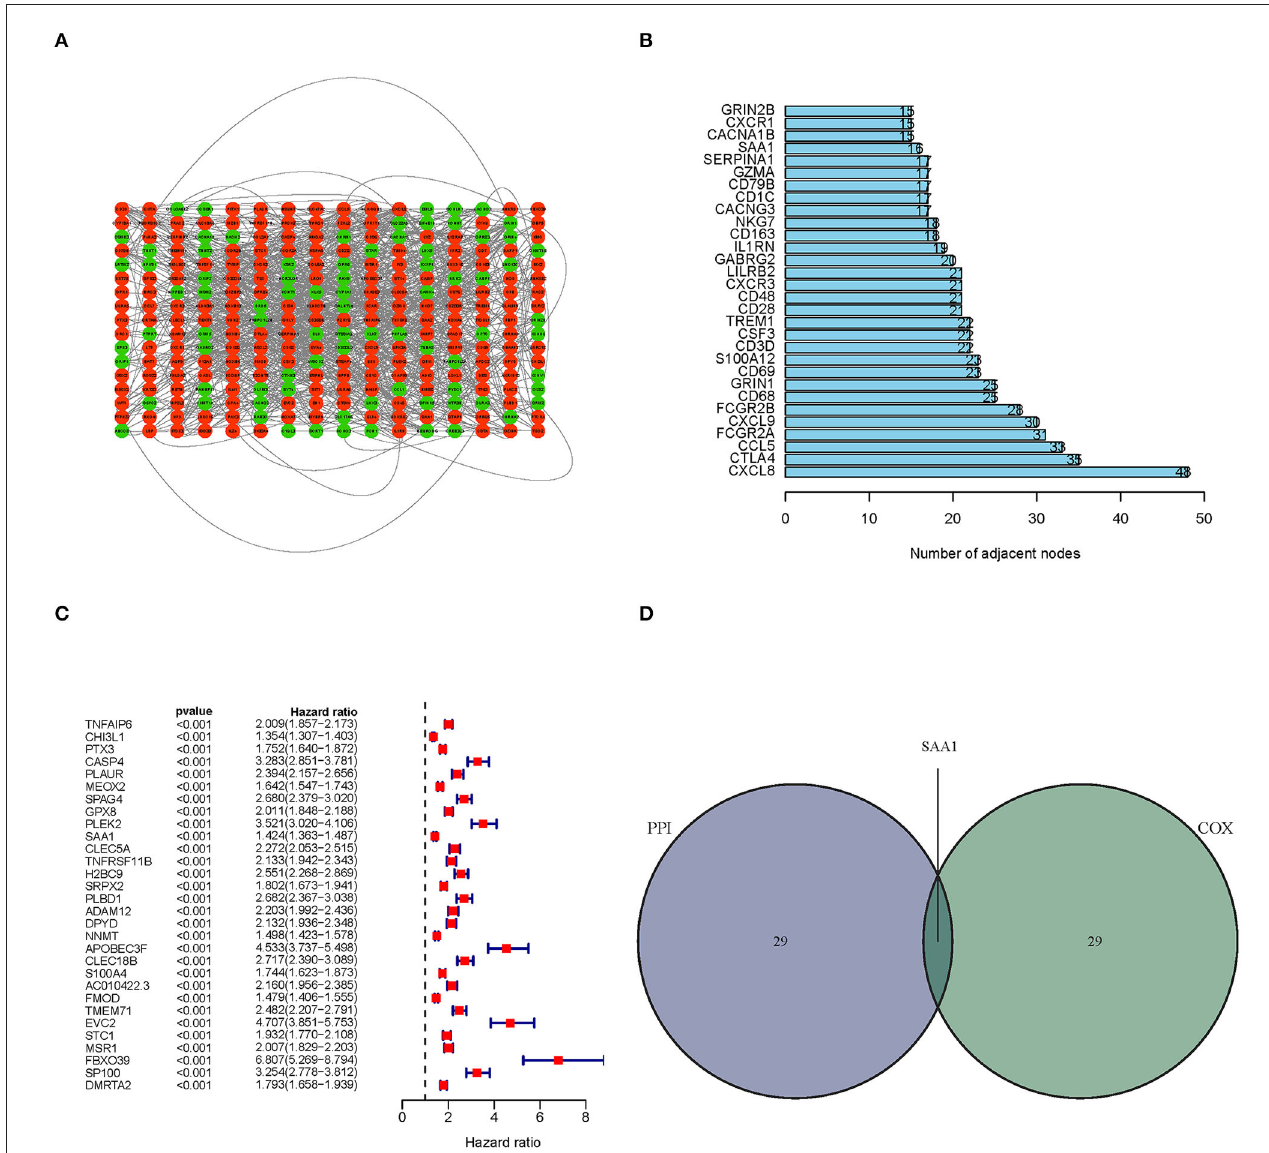
FIGURE 4 | PPI network and univariate Cox regression analyses. (A) PPI network was constructed with the TME-related genes using Cytoscape software; the interaction score was > 0.4. Red circles represent the upregulated genes; green circles represent the downregulated genes. (B) The map of the top 30 genes in the PPI network is ordered by the number of adjacent nodes. (C) Univariate Cox regression with 452 TME-related genes, listing the top 30 factors with p < 0.001. (D) The intersection of the results from the PPI and Cox regression analyses, SAA1 was identified as a TME-related gene.